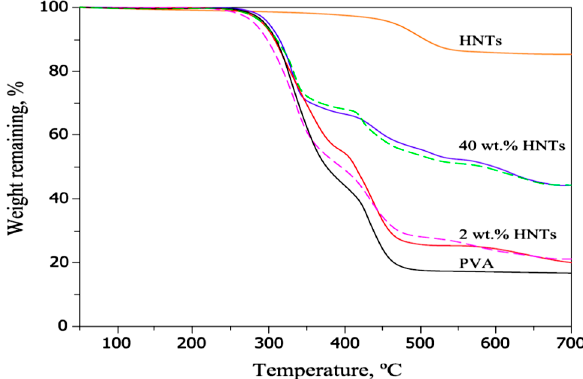
Figure 11. TGA curves of PVA, HNTs and PVA-HNT composites [3].